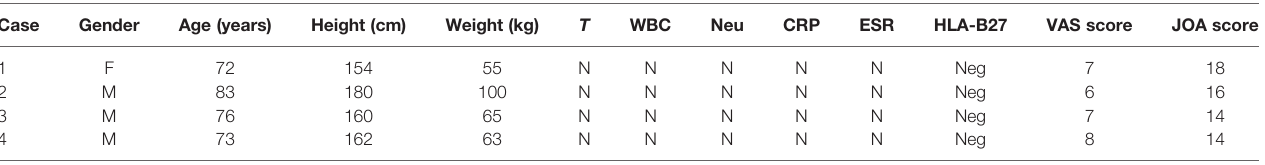
TABLE 1 | Diffuse idiopathic skeletal hyperostosis (DISH) patients before hospitalization.